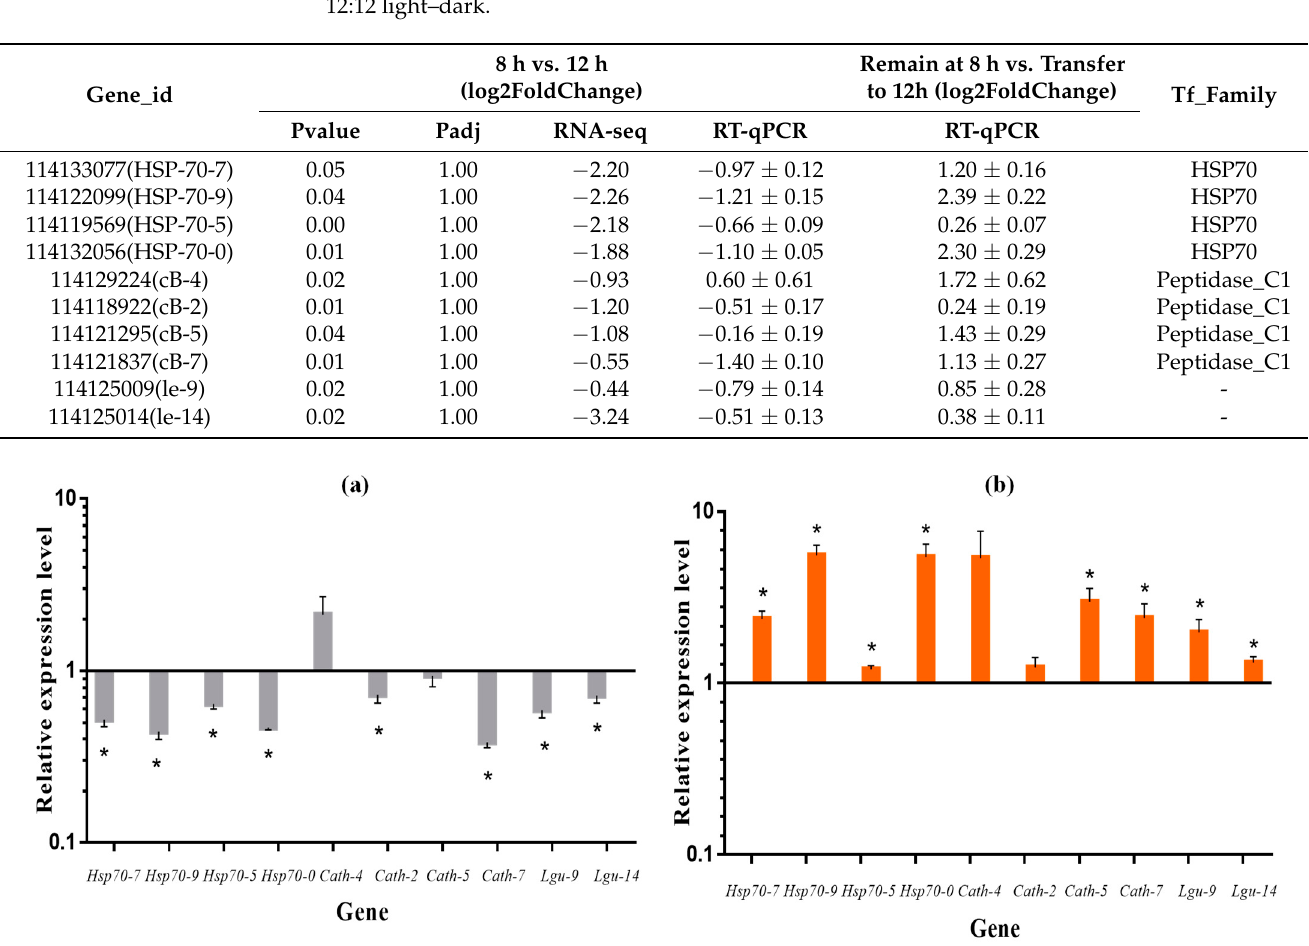
Figure 5. The relative expression levels of candidate genes in ( a ) the fifth generation Aphis gossypii between 8:16 and 12:12 (12:12 treatment as control, expression = 1) light–dark cycles; as well as ( b ): Aphis gossypii at 8:16 light–dark cycles until the seventh generation (8:16 treatment as control, expression = 1) and transferred to 12:12 light–dark cycles from the fifth generation. * Indicates a significant difference in the relative expression levels of genes ( T -test; p < 0.05).